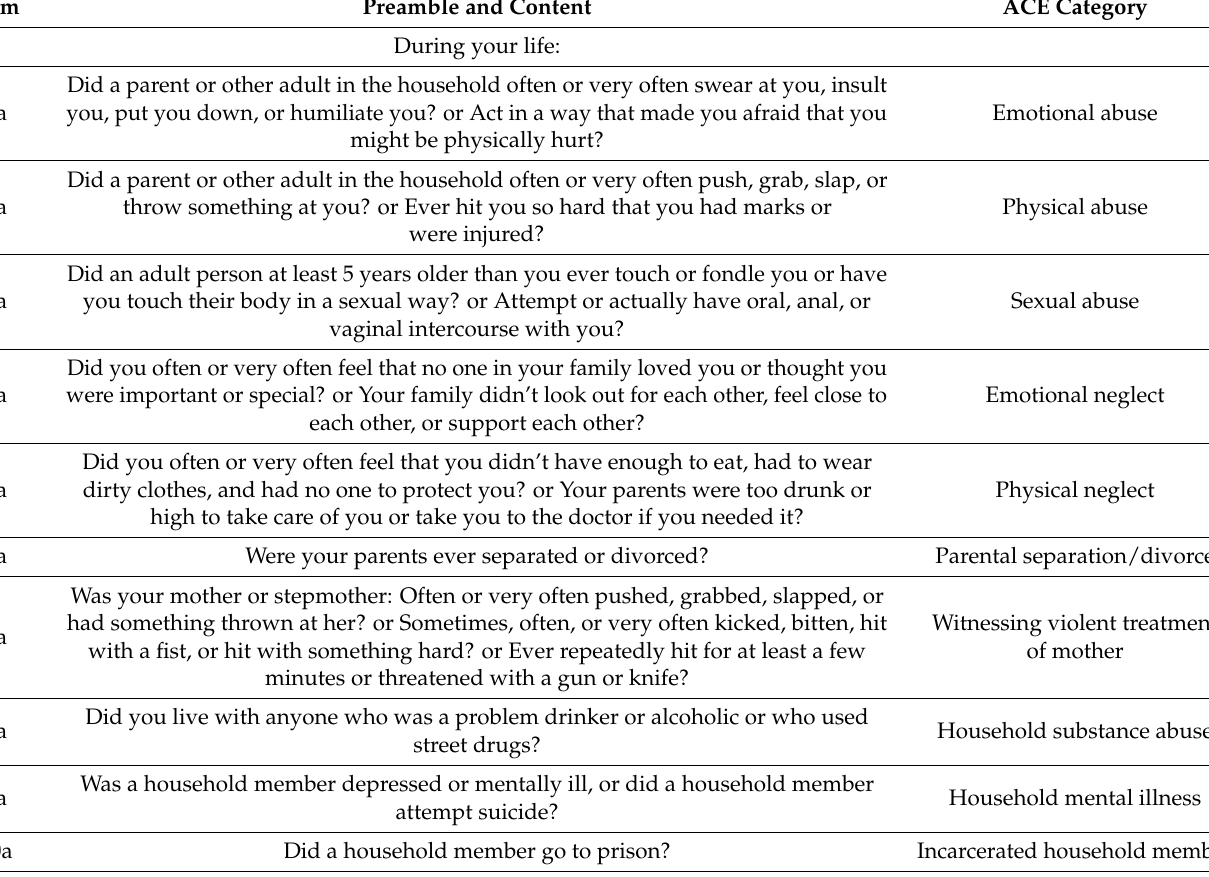
Table A1. The ACE Score Calculator—preambles, item contents and response